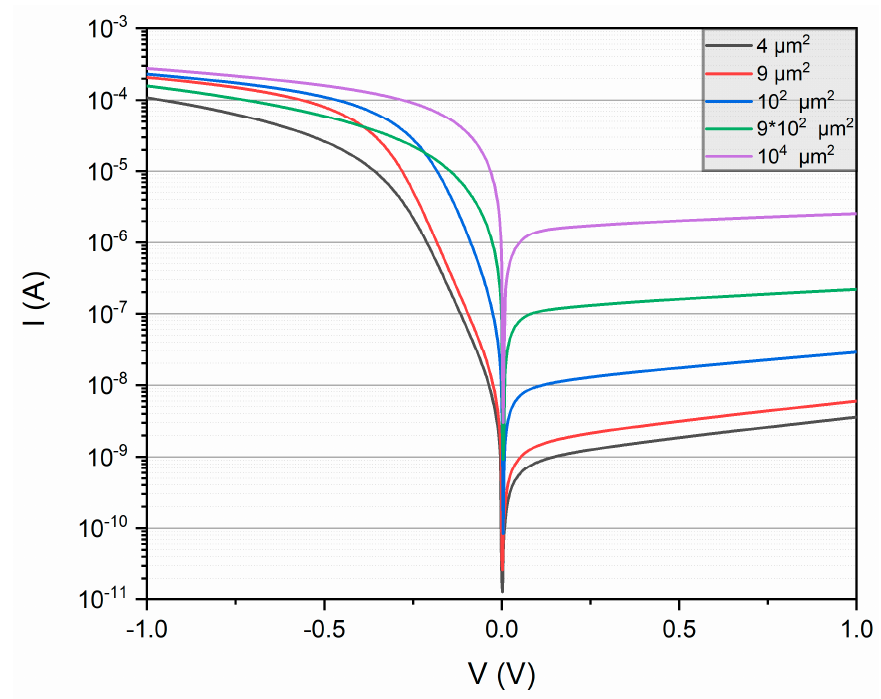
Figure 5. Current ( I ) versus applied voltage ( V ), for p + -Si 0.7 Ge 0.3 on n-type Ge diodes with area from 4 µ m 2 to 10 4 µ m 2 .